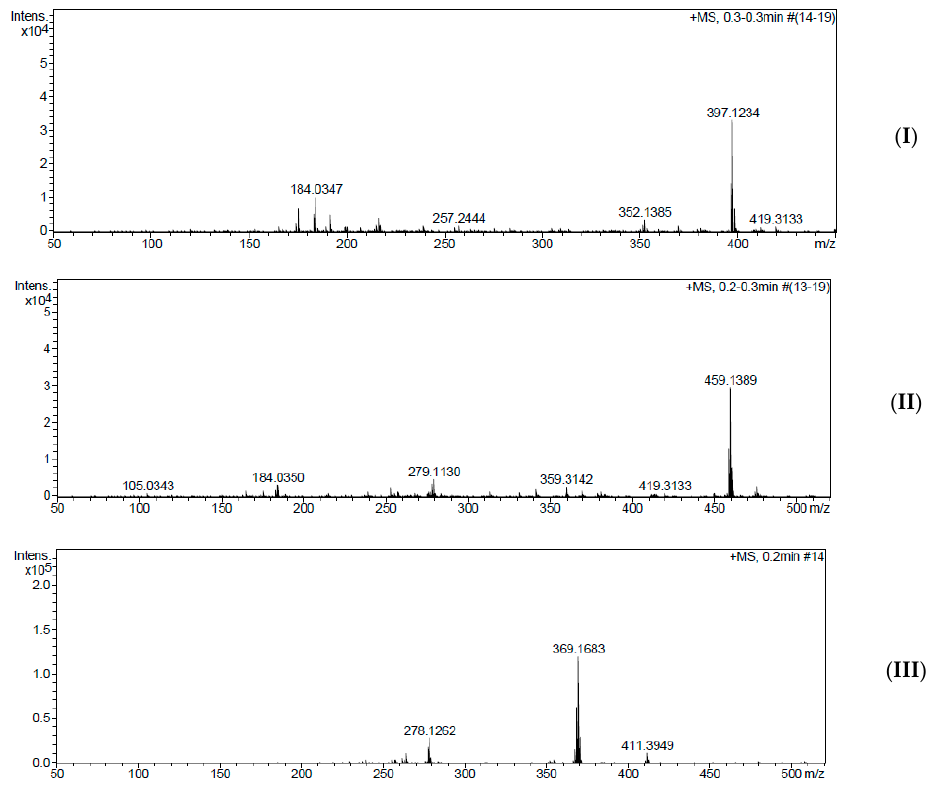
Figure 7. ( I ) Mass spectrum of Ampp-Dh; ( II ) mass spectrum of Bmpp-Dh; and ( III ) mass spectrum of Bmpp-Ph.